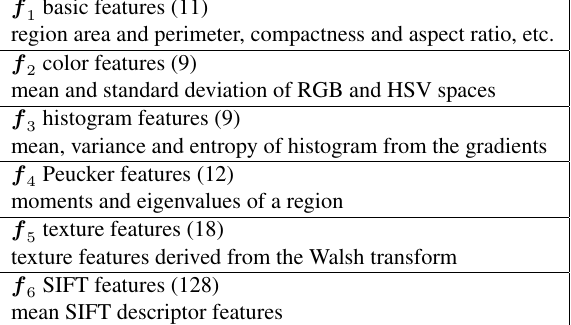
Table 1: List of derived features from image regions. The number indicates feature numbers in each feature